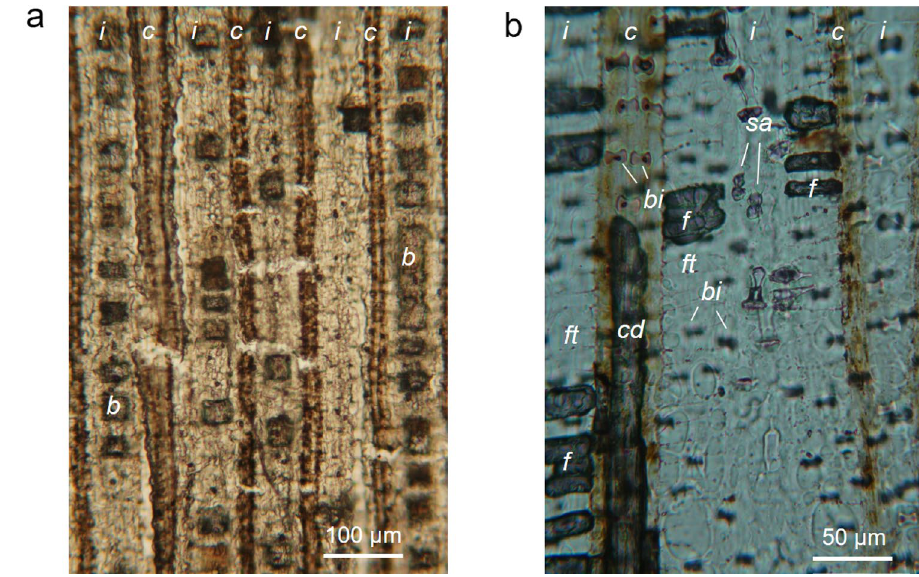
Fig. 1 Light microscope photographs of Guadua bamboo leaf after dry ashing. a Adaxial (upper) leaf surface (Primavera-2); b Mesophyll (Primavera-16). Abbreviations: i = intercostal zone, c = costal zone (leaf vein), cd = costal zone with dark inside content, b = bulliform cell, bi = bilobate short cell, sa = saddle shaped short cell, f = fusoid cell with presumed mineralization, ft = translucent fusoid